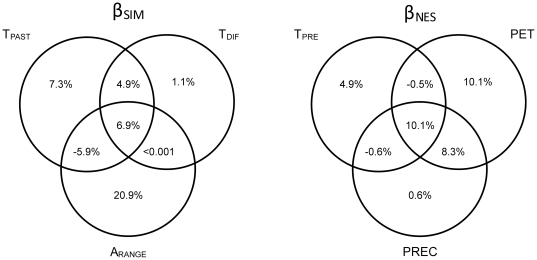
Partitioning of the variation in βSIM and βNES that can be explained by the significant predictors (see
Table 1
).TPRES = Mean annual temperature for current times; TPAST = Mean annual temperature for the LGM period; TDIF = Temperature difference between the current and LGM conditions; PET = Current mean annual potential evapotranspiration; PREC = Current annual precipitation; and ARANGE = Current altitudinal variability.